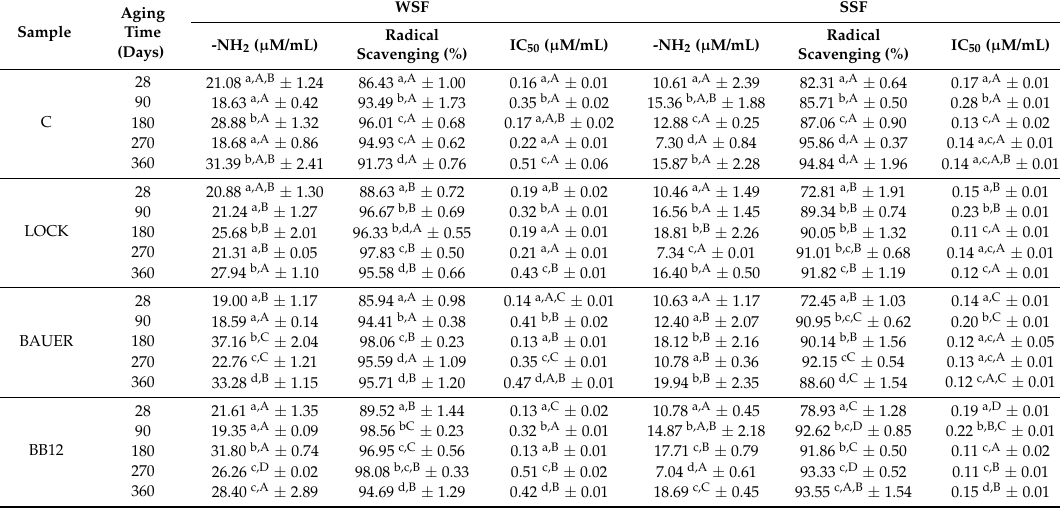
Table 5. Antiradical activity of protein hydrolysates after gastric-intestinal digestion (mean ± standard